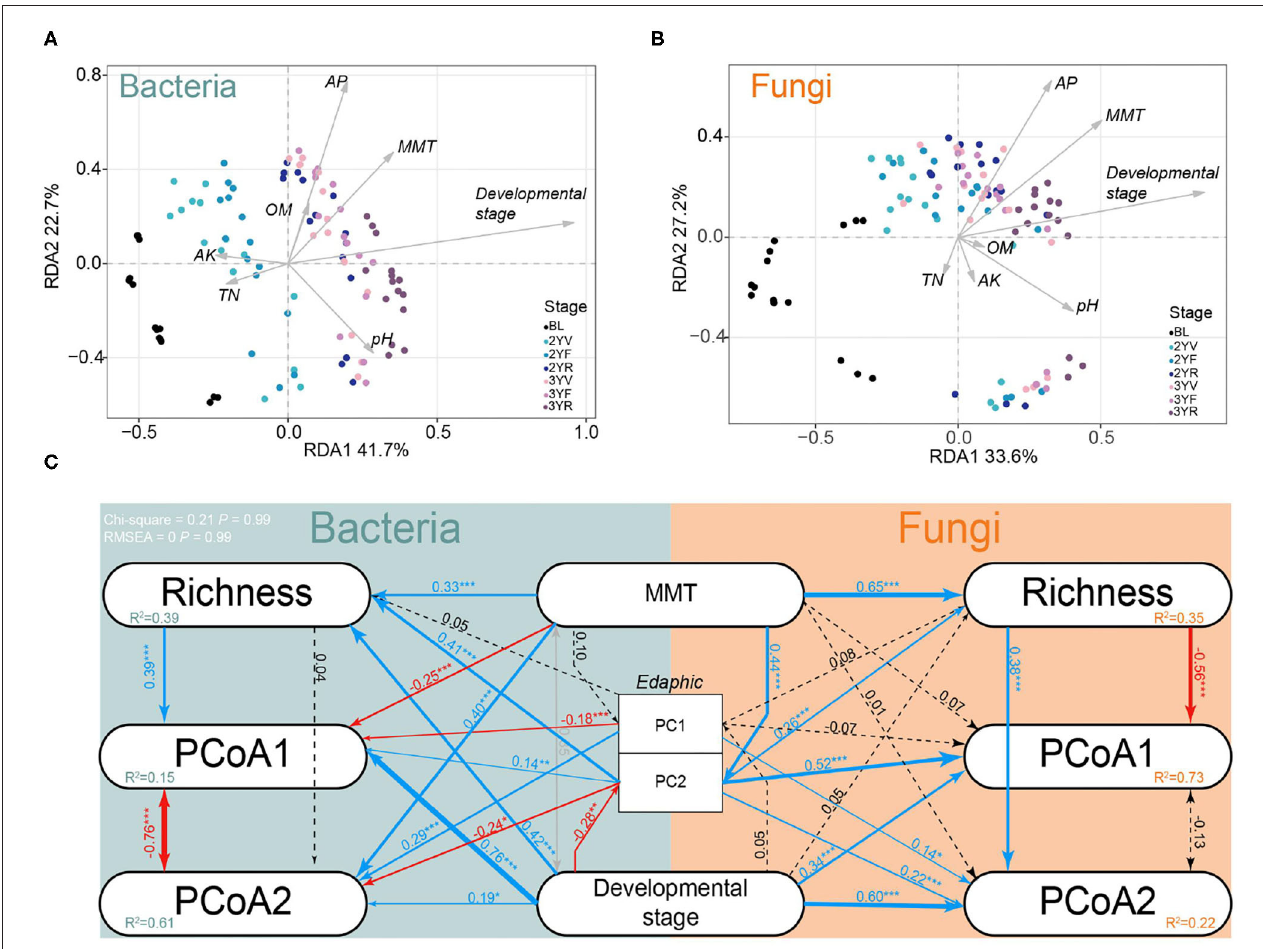
FIGURE 5 | Redundancy analysis (RDA) and structural equation model (SEM) in developmental stages sampling dataset. Effects of climatic factors, edaphic factors, and developmental stages on bacterial (A) and fungal (B) communities using RDA. MMT, month mean temperature; AK, available potassium; OM, organic matter; AP, available phosphate; TN, total nitrogen. (C) Effects of climatic factors, edaphic factors, and developmental stages on rhizosphere communities using SEM. PC1 and PC2 represent the first and second axes of principal coordinate analysis (PCoA) of edaphic factors; PCoA1 and PCoA2 represent the first and second axes of PCoA based on Bray–Curtis distances; Richness: OTU richness. MMT: month mean temperature. Solid lines represent significant ( P < 0.1) path coefficients (blue, positive; red, negative), and dotted lines represent paths with P ≥ 0.1. The gray line represents the correlation between independent variables. R 2 represents variance explained by the